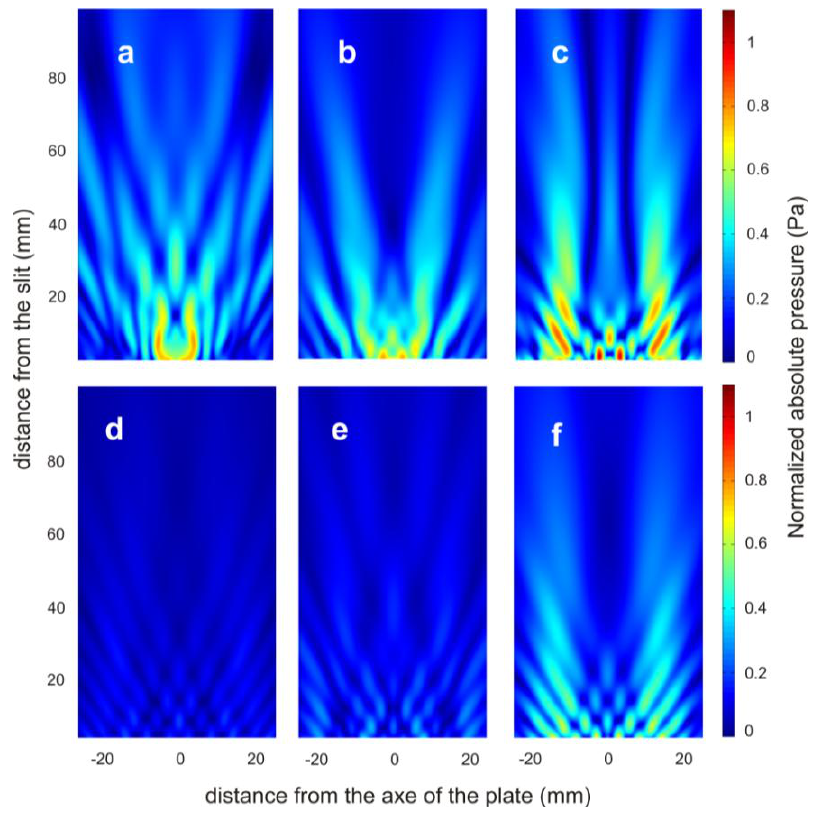
Figure 4. The normalized absolute pressure simulated field maps in the XZ plane of groove-grating with central slit plate for a groove depth of ( a ) 1 mm, ( b ) 2 mm and ( c ) 3 mm and